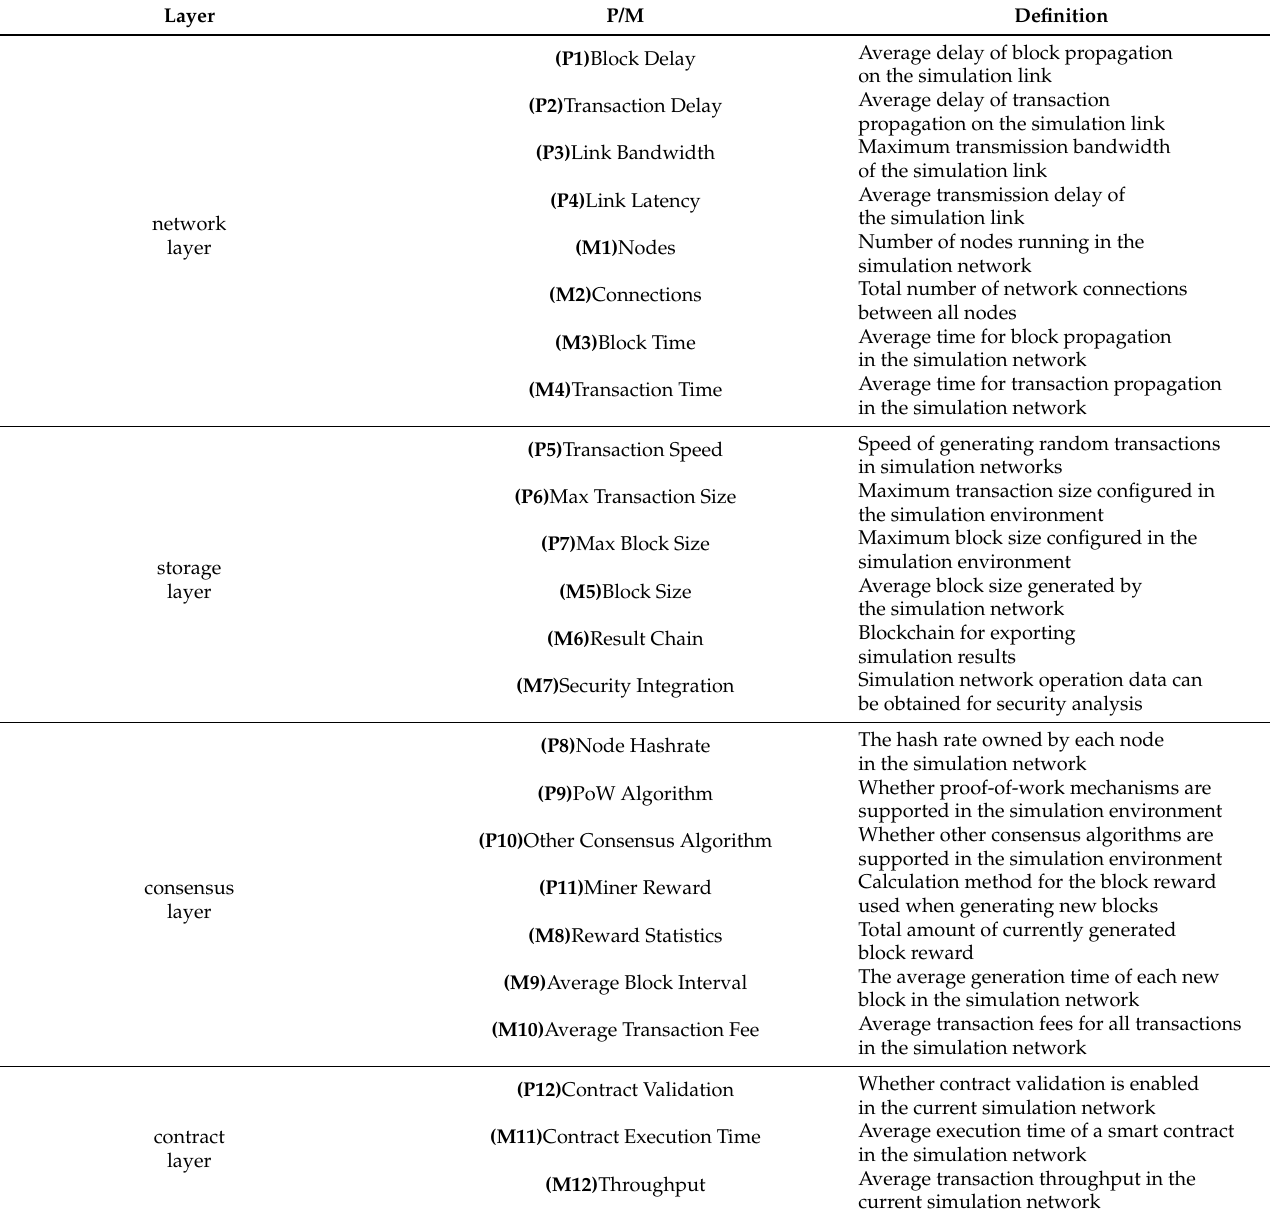
Table 1. Parameters and metrics supported by the simulation